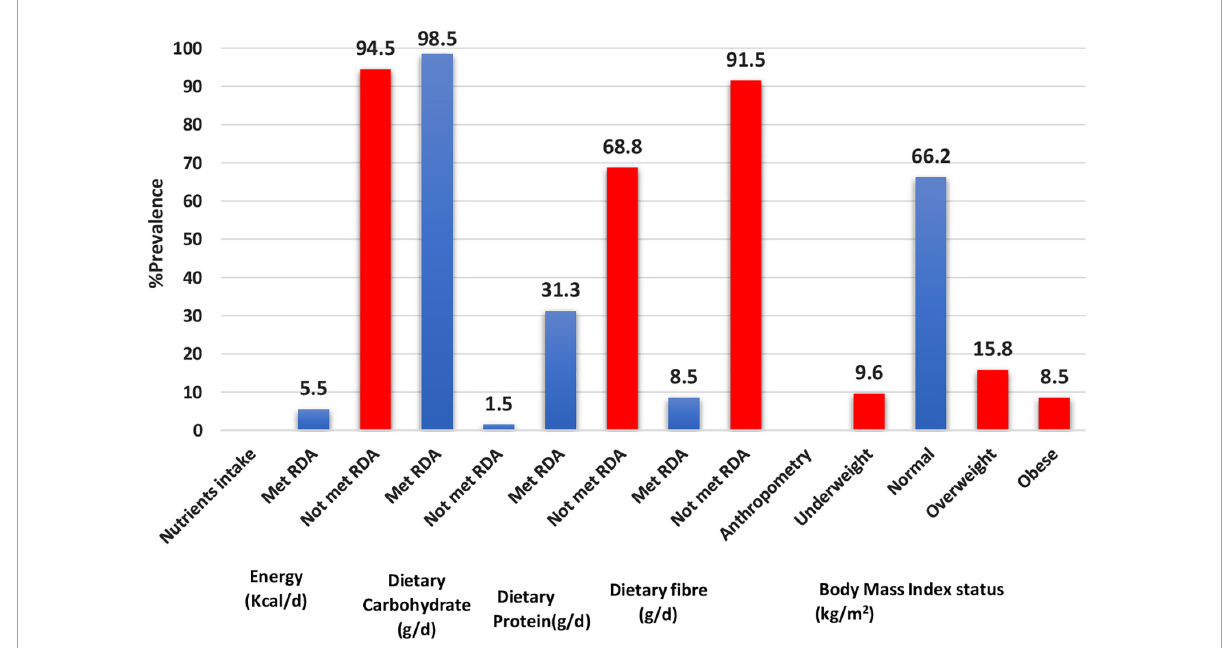
FIGURE1 Adequacies and inadequacies in calories and macronutrient intakes, and BMI status.